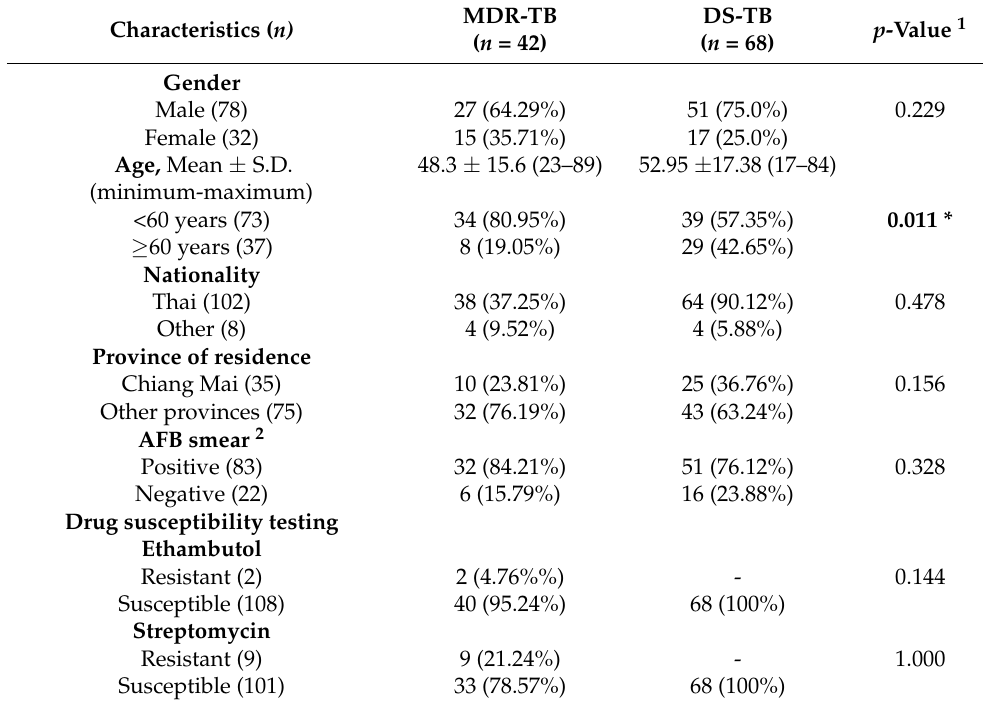
Table 3. The demographics and clinical characteristics among multidrug-resistant tuberculosis (MDR-TB) and drug-susceptible tuberculosis